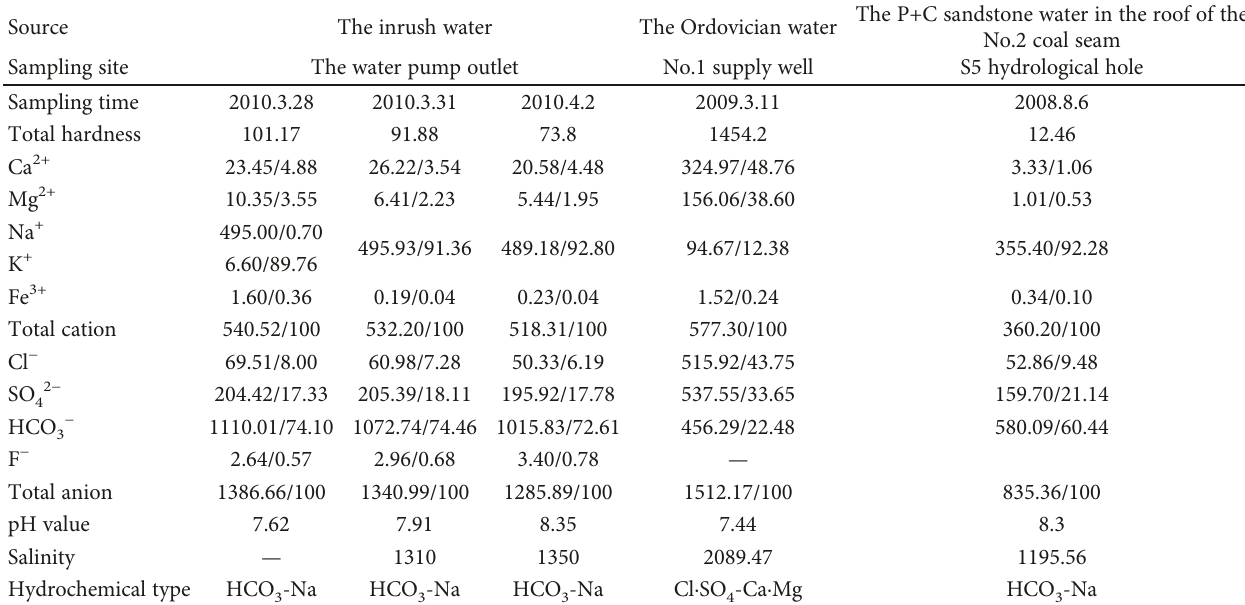
Table 1: Results of the groundwater quality analysis unit: mg ⋅ l − 1